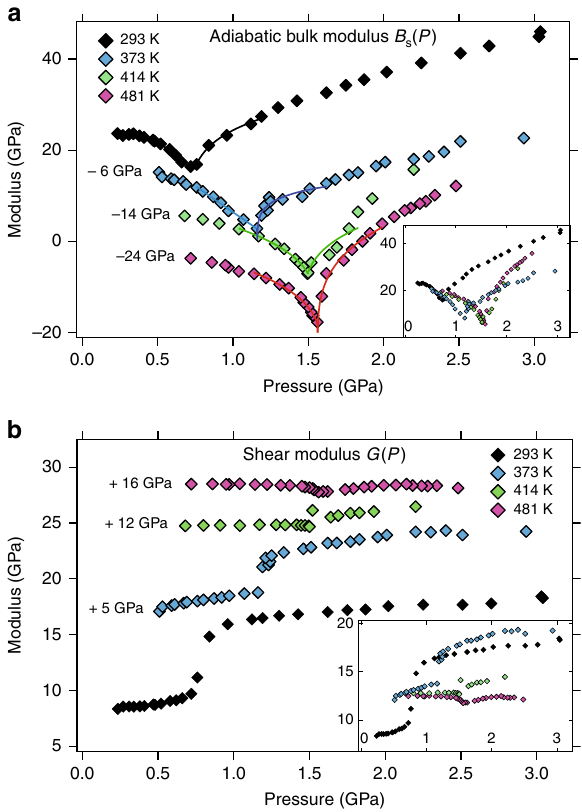
Fig. 3 Pressure dependence of the adiabatic bulk and shear moduli. a Values for the adiabatic bulk modulus B S = ρ ( c L 2 − 4/3 c T 2 ) are shown for different isotherms. Width and depth of the transition for B S become narrower and deeper with the temperature approaching the critical temperature T C . A similar behavior has been observed for the isothermal bulk modulus B T above T C where the width of the transition becomes wider and the minimum shallower with further distance from T C . At T C itself B T vanishes at the critical pressure P C 10, 11 . The solid lines are the fi ts of a power law B S ( P ) ~ | P − P VC | α to the data. b Values for the shear modulus G = 2 at different temperatures. Uncertainty in pressure ( < 0.05 GPa) and ρ c T modulus ( < 3%) is within symbol